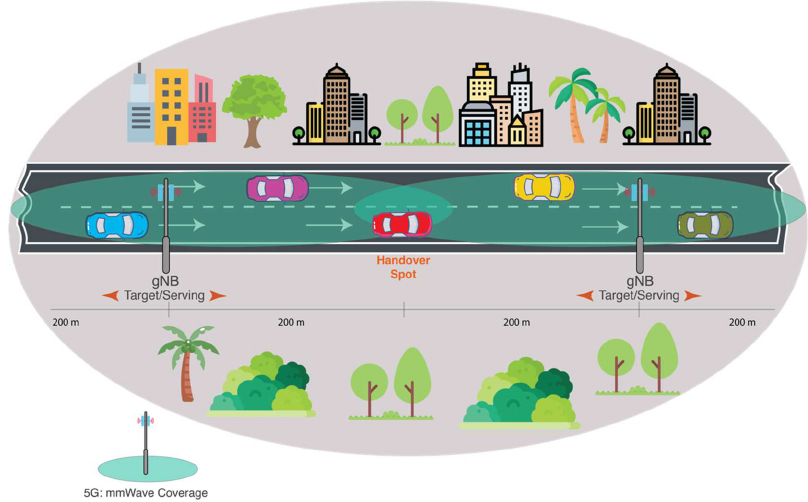
Figure 3. B5G network deployment scenario.